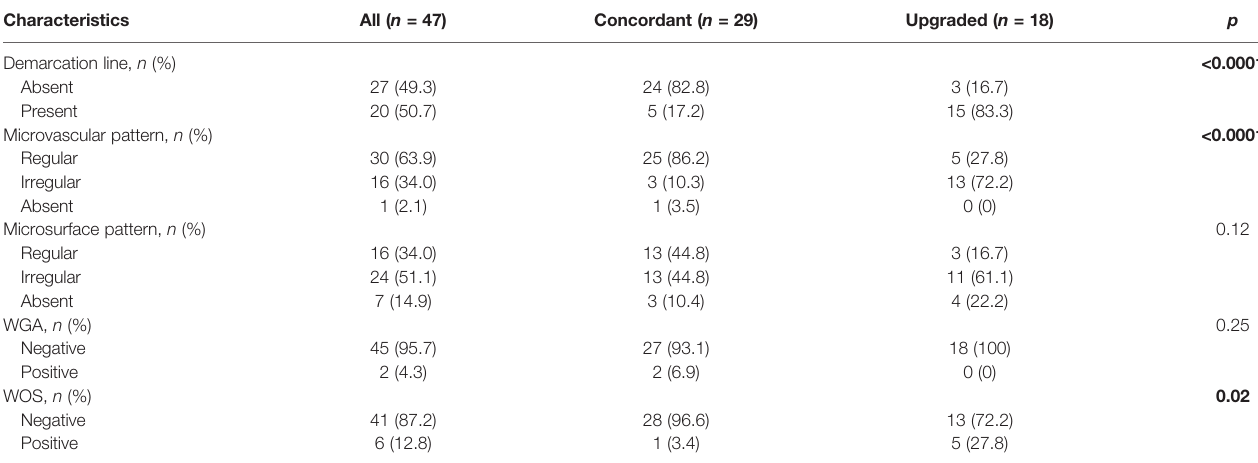
TABLE 3 | Characteristics of the study patients using NBI between concordant and upgraded